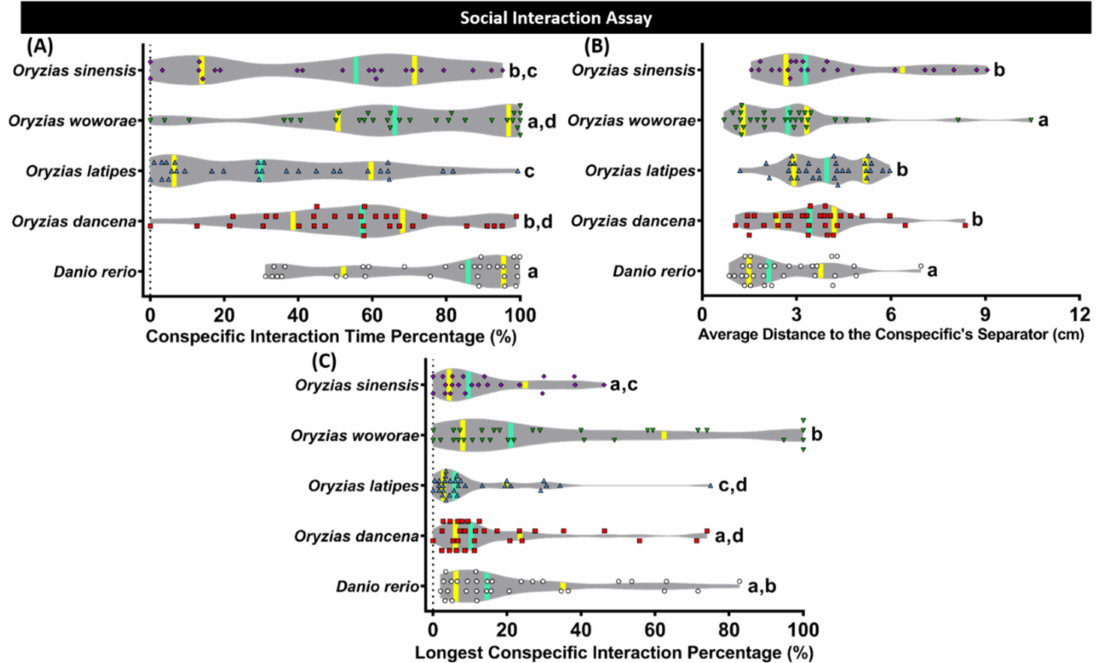
Figure 3. Conspecific social interaction behavior comparisons between each tested fish species (medaka and zebrafish). ( A ) Conspecific interaction time percentage, ( B ) average distance to the conspecifics separator, and ( C ) longest conspecific interaction percentage were analyzed. The data were analyzed by the Kruskal–Wallis test continued with uncorrected Dunn’s test. Different letters (a, b, c, d) on the error bars represent a significant statistical difference ( p < 0.05) ( n = 30 for zebrafish, O. dancena , O. latipes , and O. woworae ; n = 21 for O. sinensis ). The median and interquartile for the violin plot were labeled with the bold line colored with cyan and